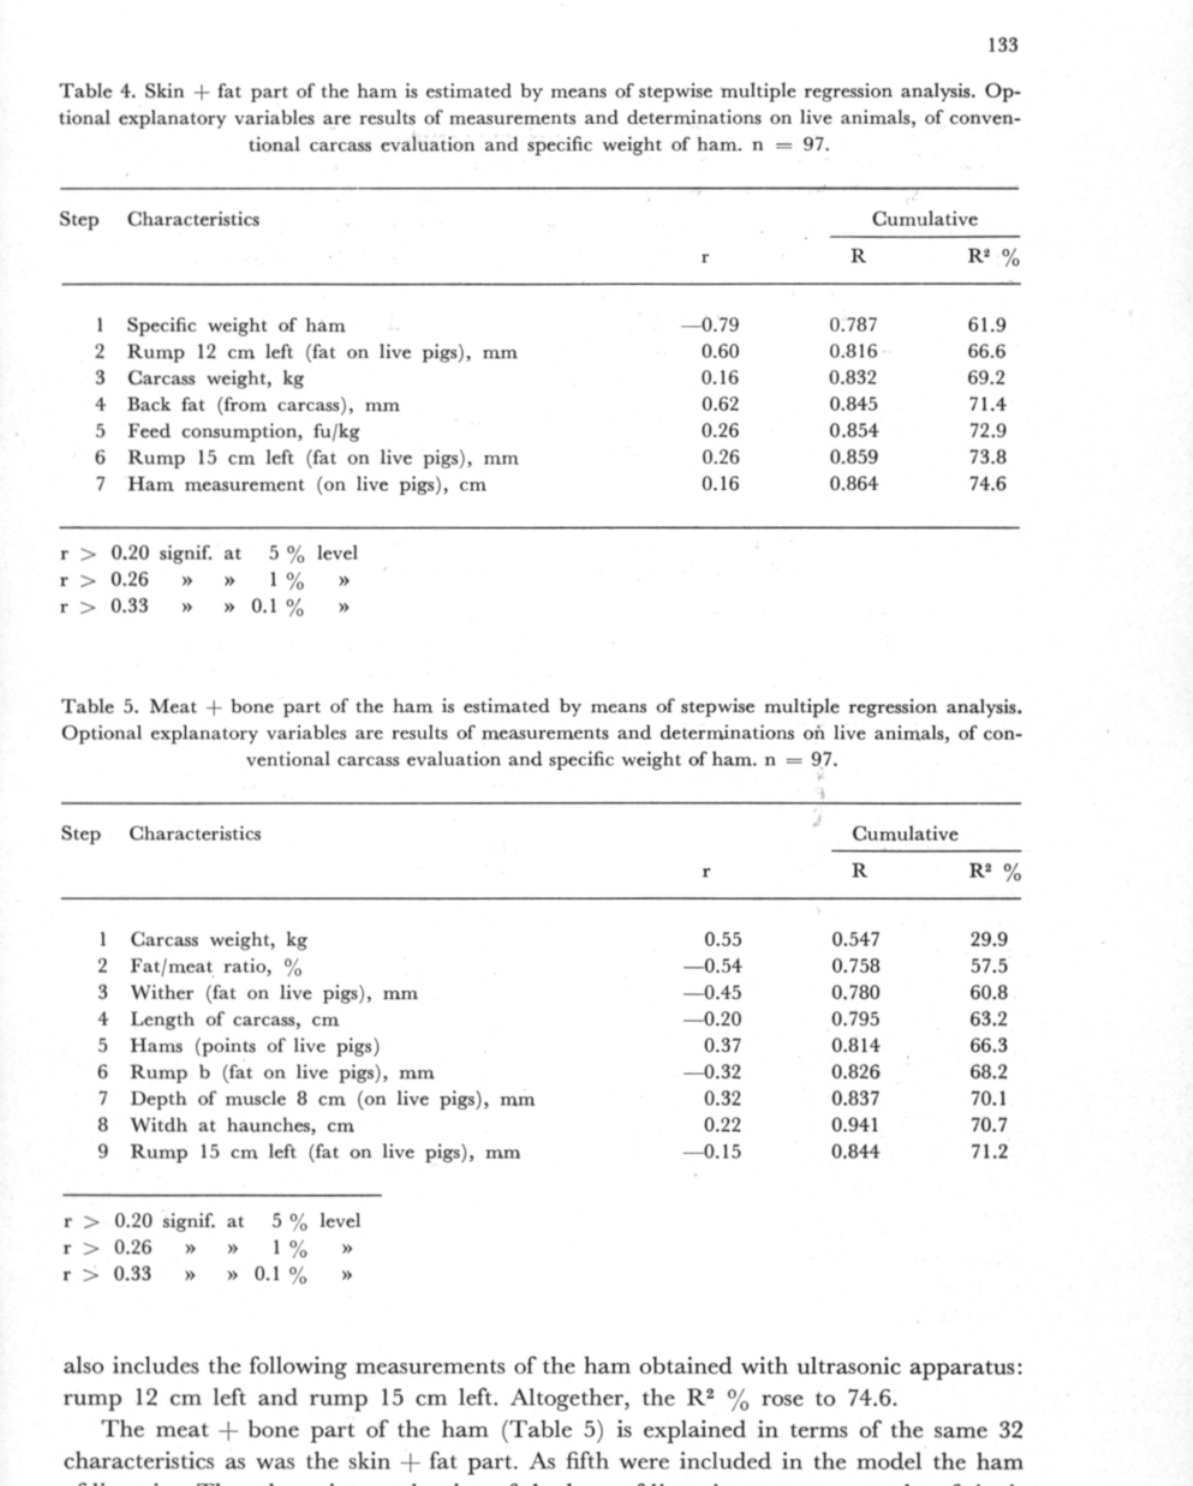
Table 4. Skin ■+■ fat part of the ham is estimated by means of stepwise multiple regression analysis. Op- tional explanatory variables are results of measurements and determinations on live animals, of conven- tional carcass evaluation and specific weight of ham. n